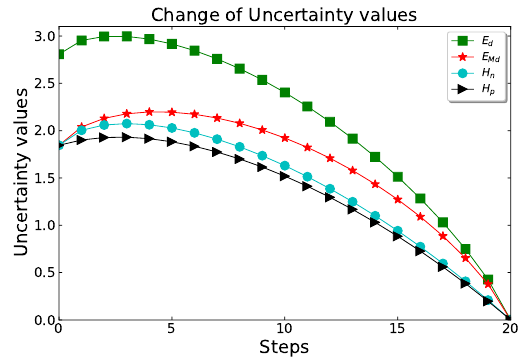
Figure 4. The change of uncertainty values in Example